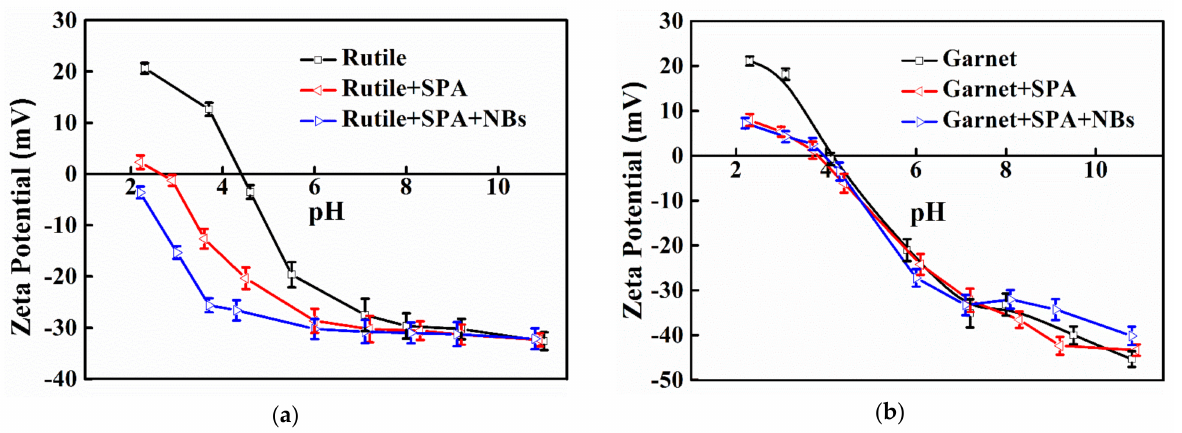
Figure 4. Effects of SPA and nanobubbles on zeta potential of rutile ( a ) and garnet ( b )